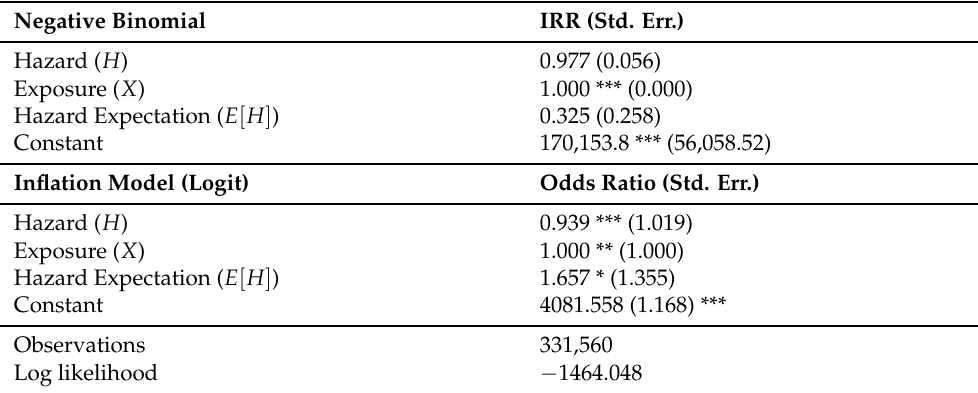
Table 3. Adaptation model calibration: zero-inflated negative binomial estimates of flooding damage (USD) in the CRB 1997–2017 (monetary values in 2017 prices). Negative Binomial IRR (Std.